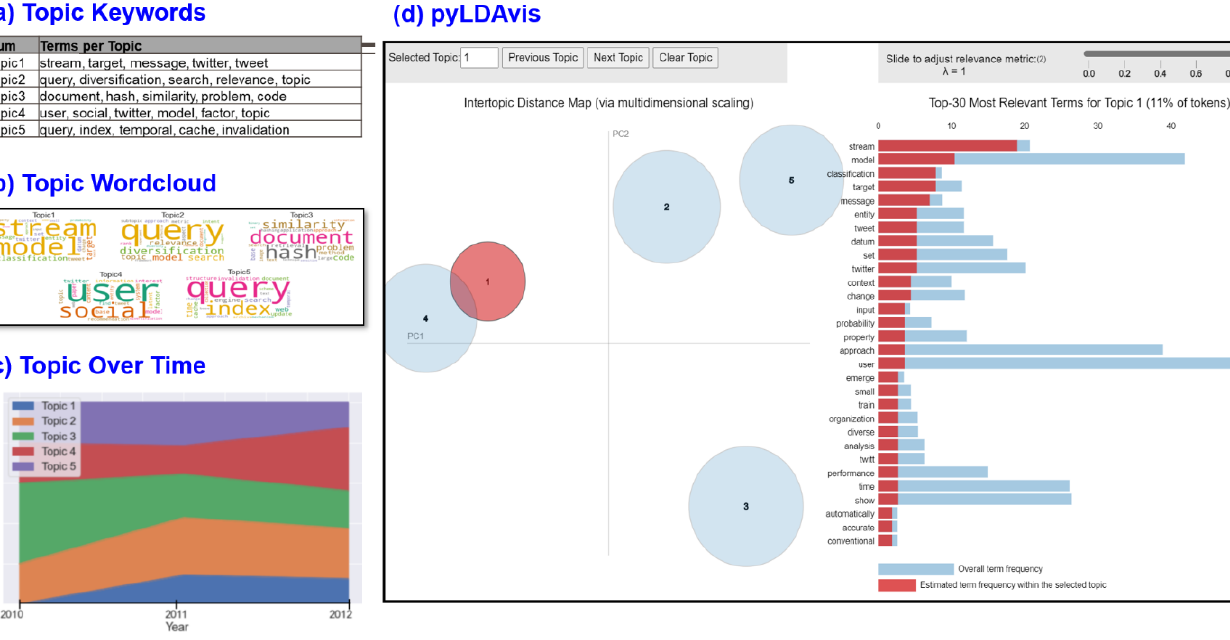
Figure 12. Sample topic visualization for SIGIR dataset at (K = 5).